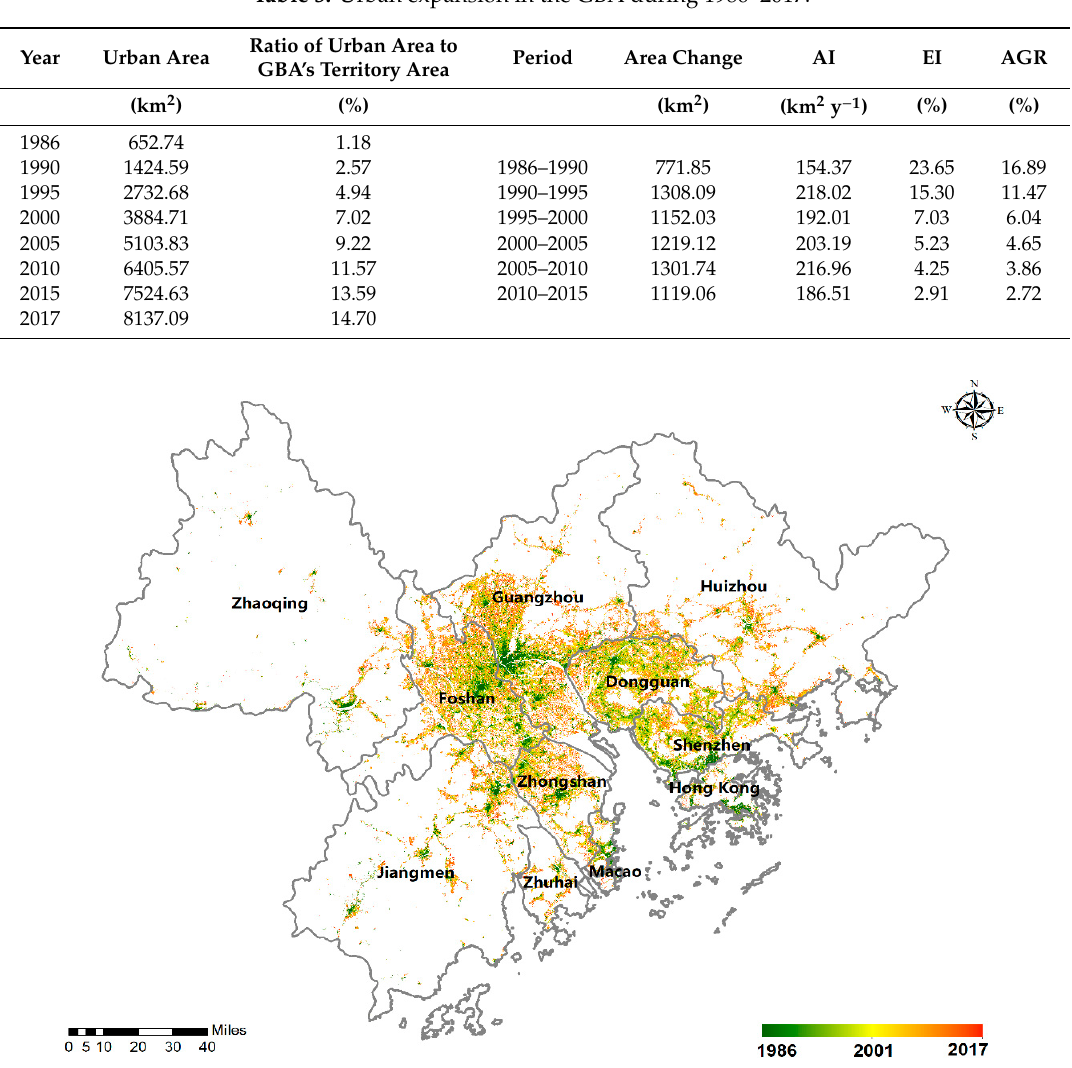
Table 3. Urban expansion in the GBA during 1986–2017.